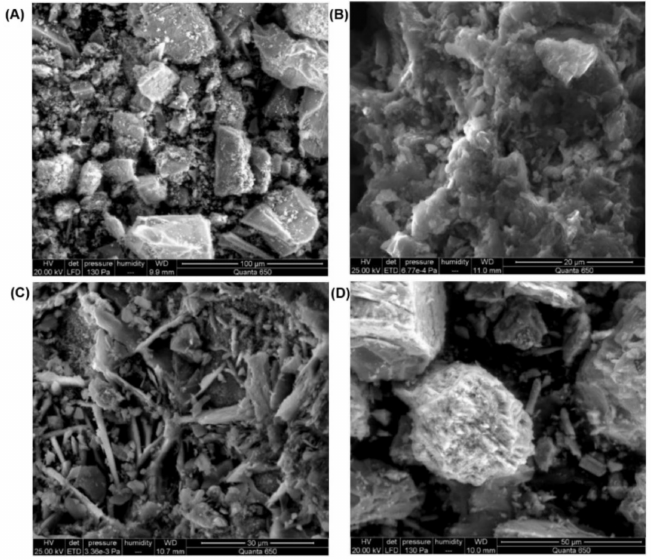
Figure 6. Electron microscope image of corrosion products of iron anchor block. ( A – D ) are four sample micrographs. ( A ) Bulk corrosion products; ( B ) granular corrosion products; ( C ) needle-like corrosion products; ( D ) spherical corrosion